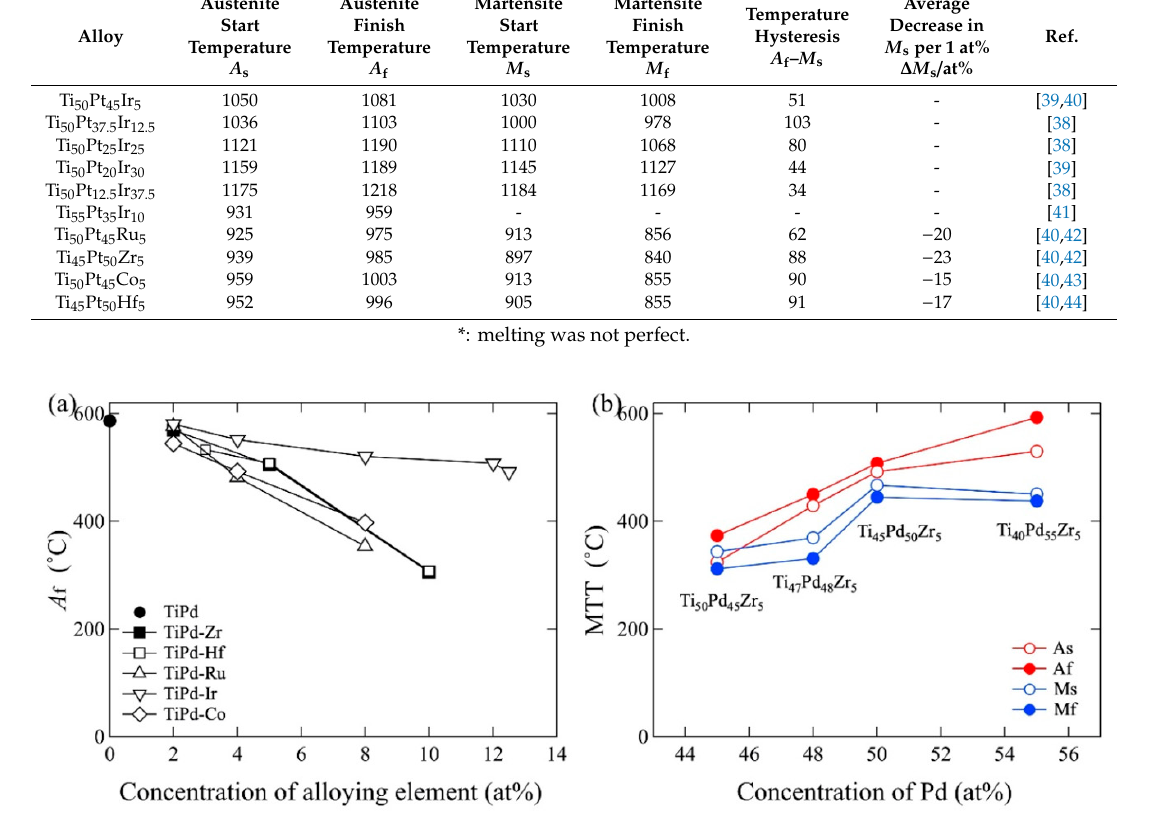
Figure 1. ( a ) Austenite finish temperature change for concentration of alloying element of TiPd [33], TiPd-Zr [33,36], TiPd-Hf [34], TiPd-Ru [37], TiPd-Ir [37], and TiPd-Co [37], and ( b ) martensite transformation temperature for concentration of Pd of Ti 50 Pd 45 Zr 5 , Ti 47 Pd 48 Zr 5 , Ti 45 Pd 50 Zr 5 [33], and Ti 40 Pd 55 Zr 5 [35].